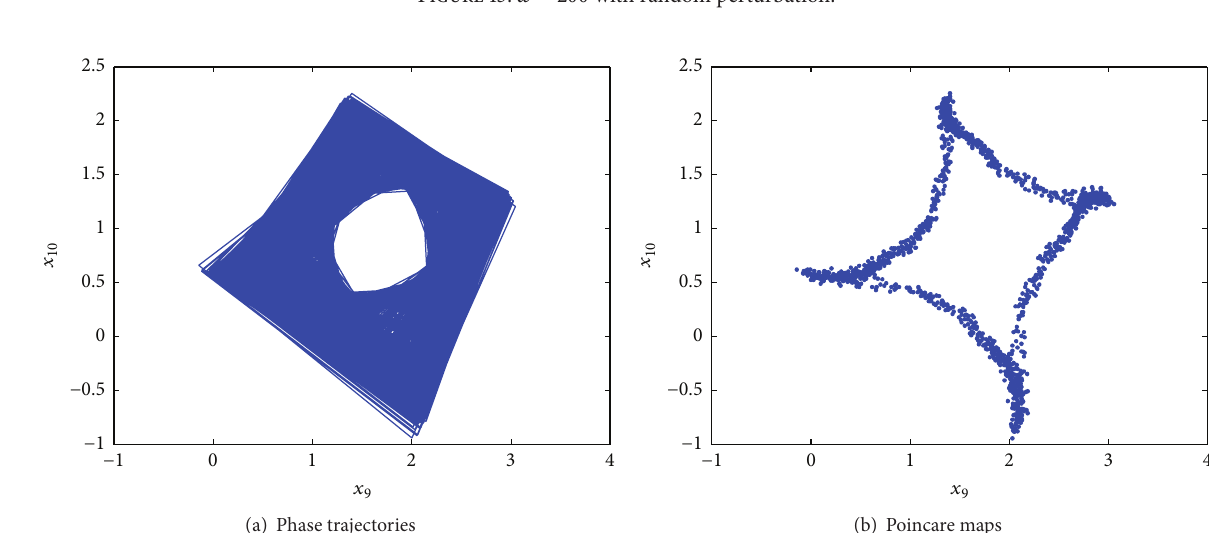
Figure 13: 𝜔 = 200 with random perturbation.